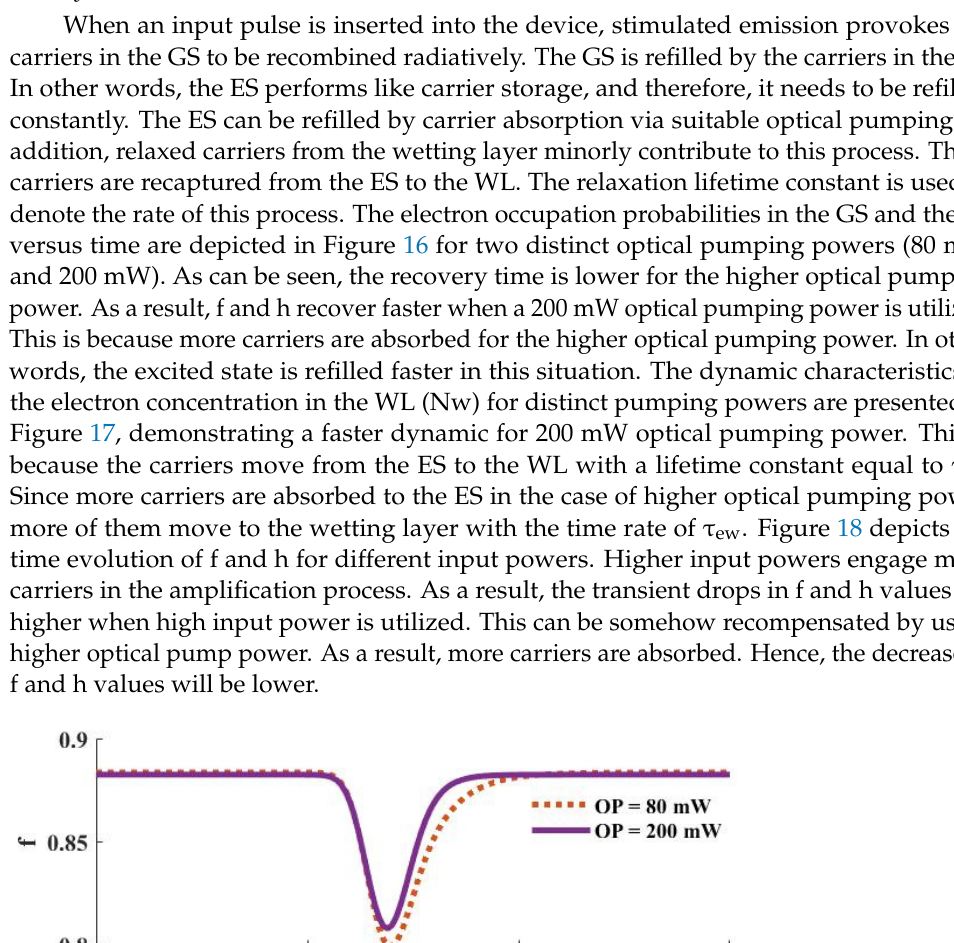
Figure 17. The electron concentration in the wetting layer for distinct optical pump power (input signal power = 1 μ W).